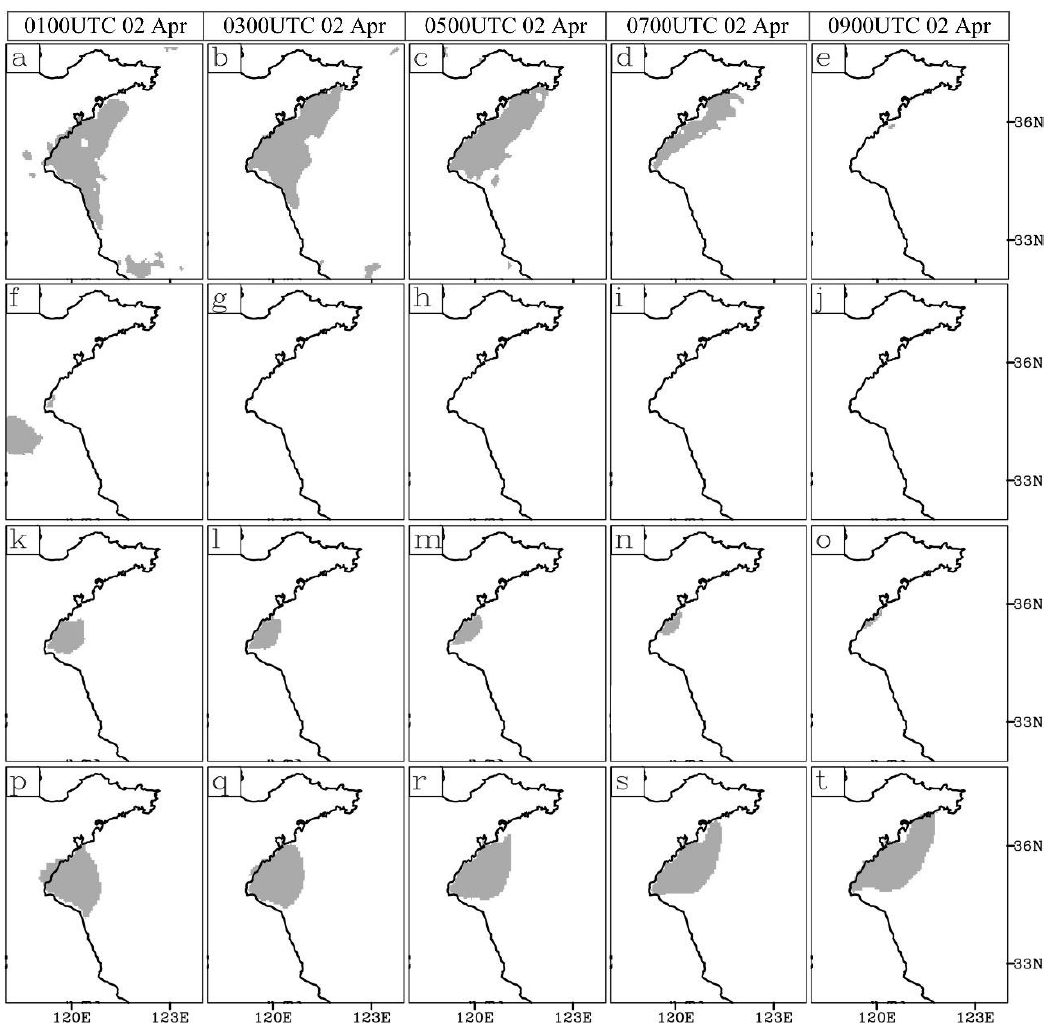
Figure 5. ( a – t ) As in Figure 4, but for Exp-B1, Exp-B2, and Exp-B3 of the case C-14.